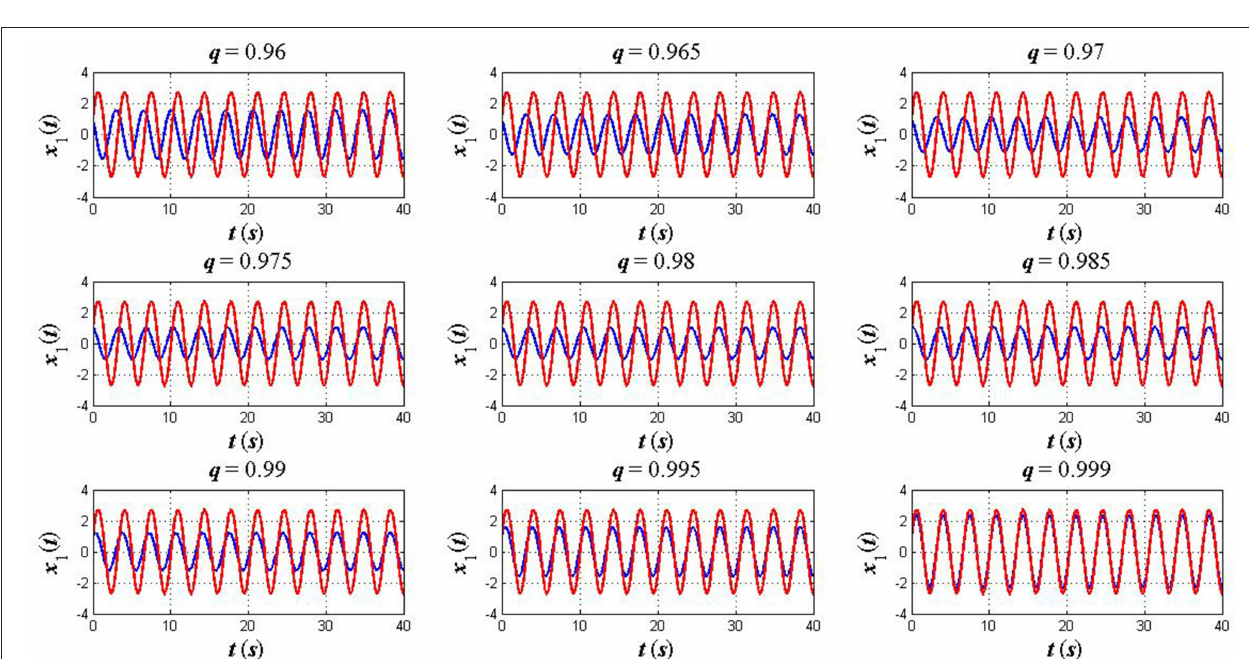
FIGURE 6 | The plots of x 1 ( t ) in the fractional sense (blue) and classical sense (red): a weak coupled oscillator ( k ≫ k 2 ).